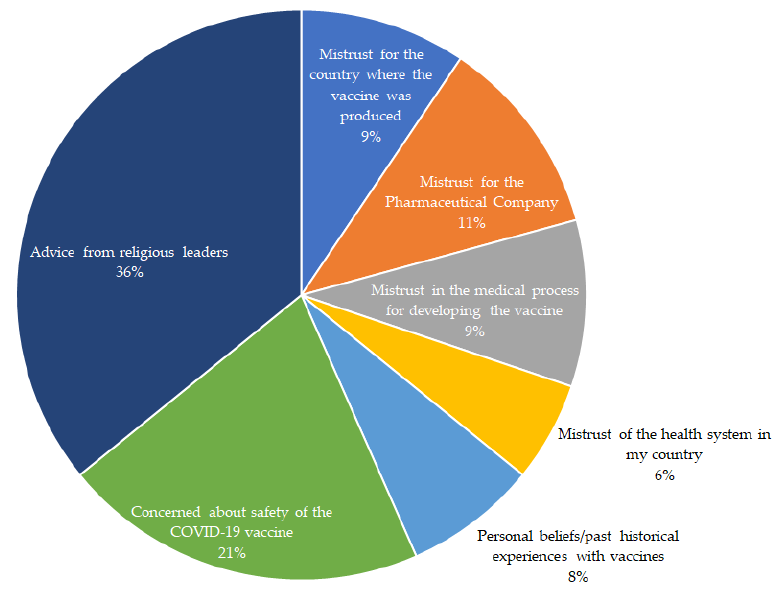
Figure 5. Main reasons for vaccine hesitancy or refusal among people with diabetes ( n = 19).